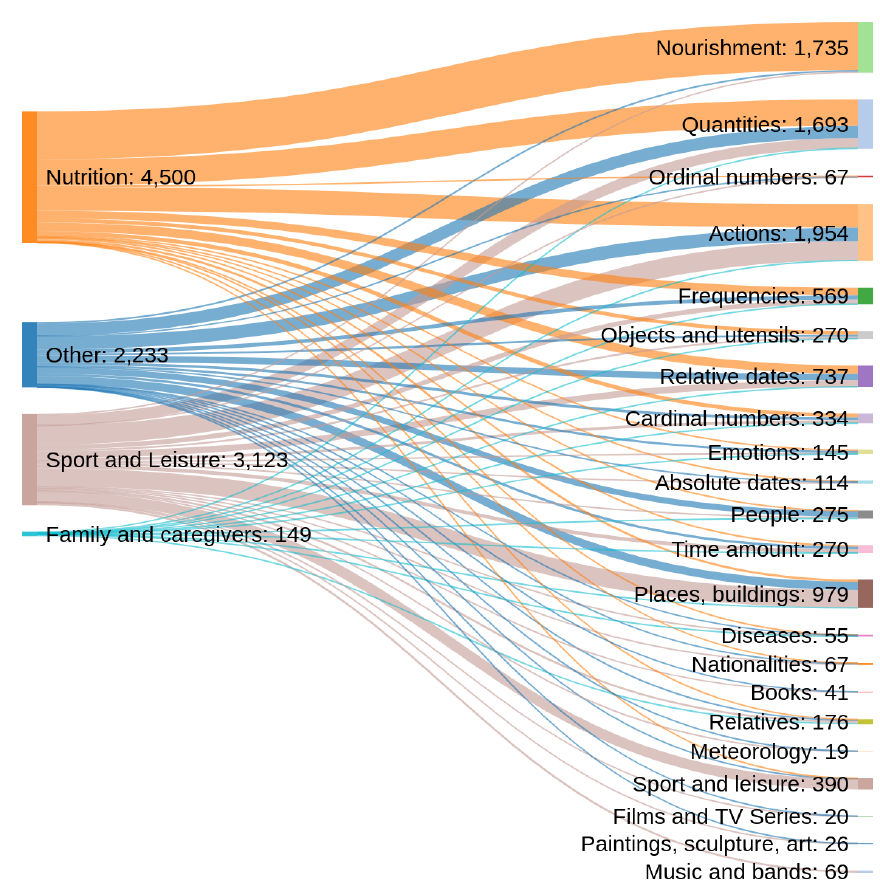
Figure 7. Relation between topic and